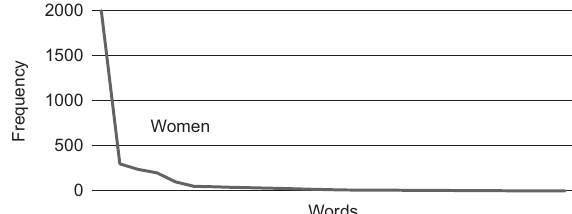
Fig. 7. Synthesis of lexical occurrences analysis of the